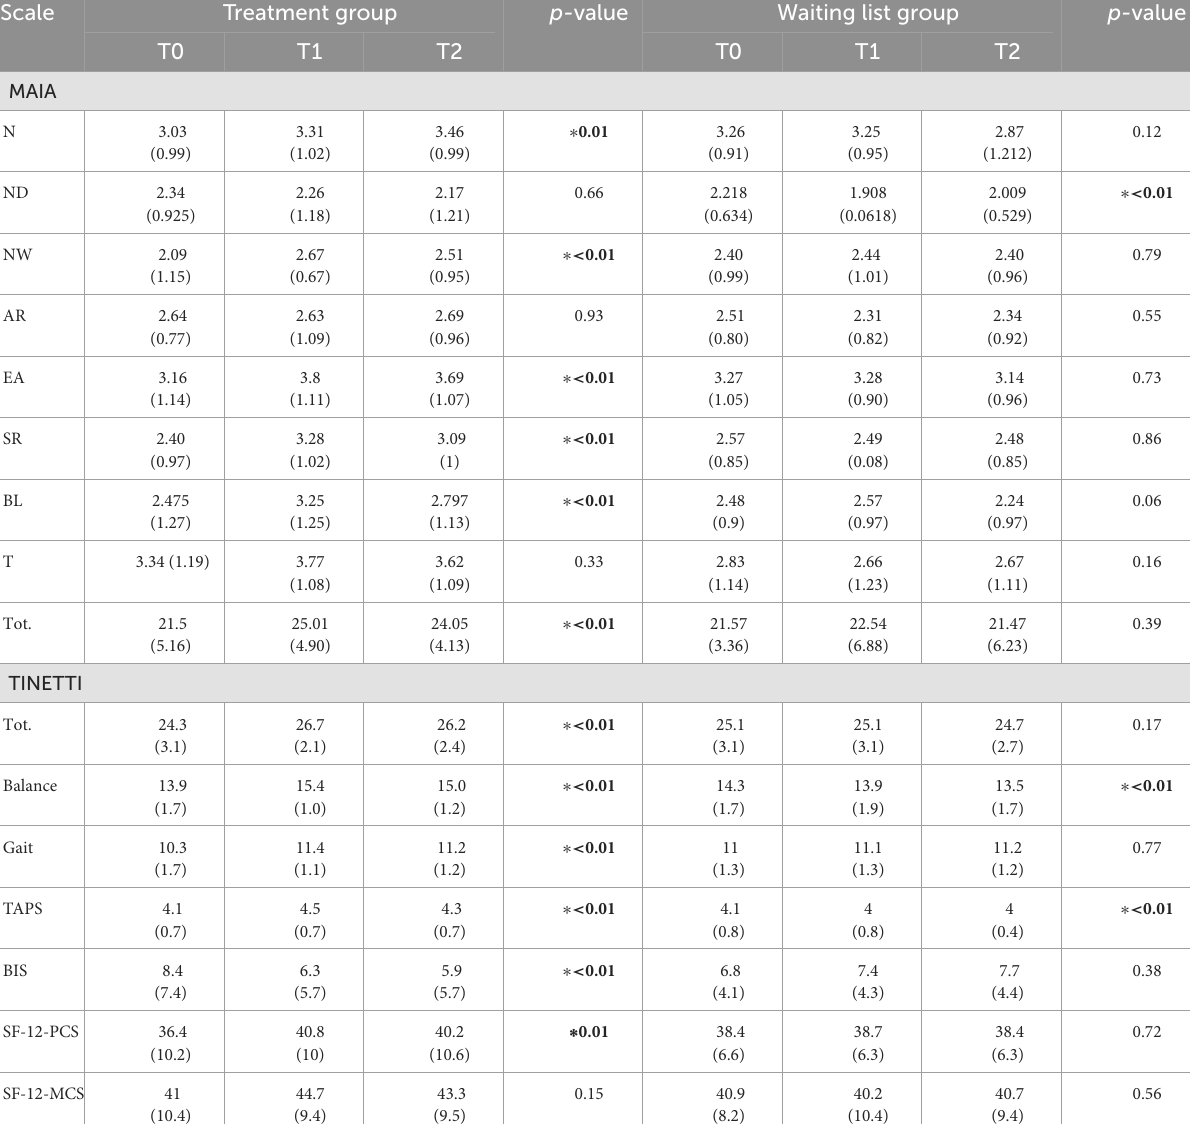
TABLE 3 Mean values, standard deviations and p- values of clinical scale scores at three timepoints in the two groups. Scale Treatment group p-